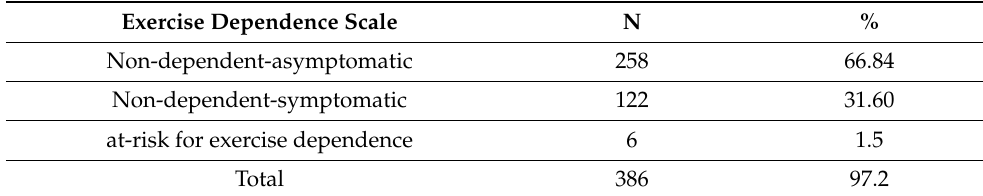
Figure 1. Sample distribution by age. Table 1. Frequency Exercise Dependence Scale.